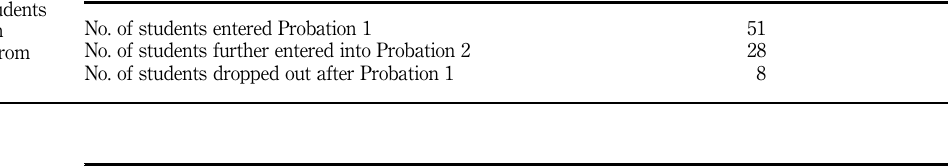
deteriorated in their studies from